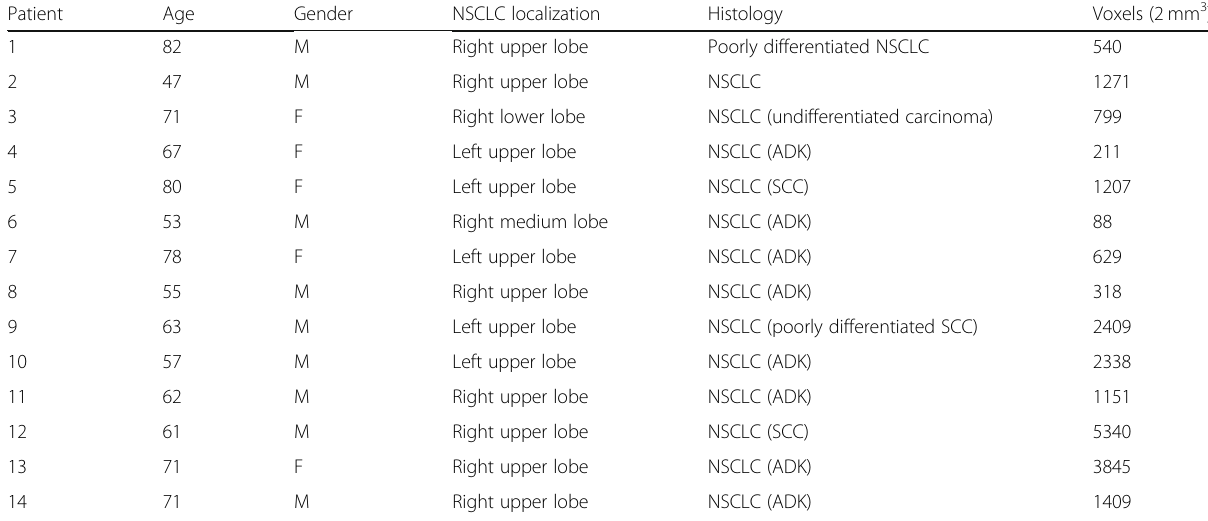
Table 1 Patients characteristics